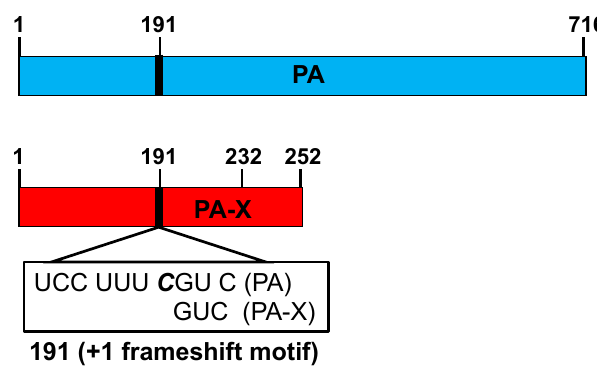
Figure 4. A schematic representation of the IAV PA viral segment and the PA and PA-X open reading frames (ORFs). Blue and red boxes indicate the ORF for PA and PA-X, respectively. The +1 frameshift motif (UCC UUU C GU C) at position 191 is indicated. Bold and italics in the frameshift motif (C nucleotide) indicate that the nucleotide C is not read during PA-X translation. PA-X proteins containing 232 or 252 amino acids if the C-terminal region has a 41 or 61 amino acid extension, respectively, are indicated.